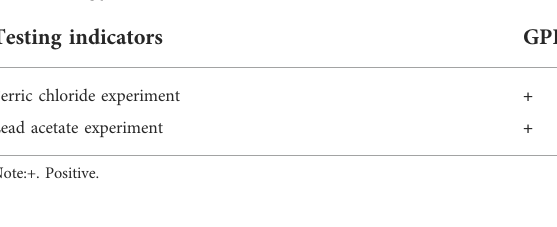
TABLE 1 Polyphenol identi fi cation reaction of